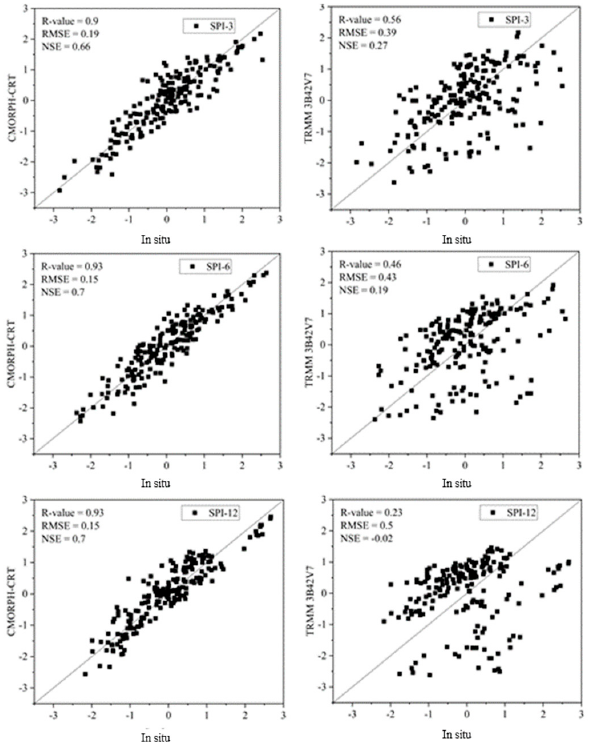
Figure 8. Comparison of the SPI-3, SPI-6, and SPI-12 calculated from the satellite-based precipitation products and in situ observations.